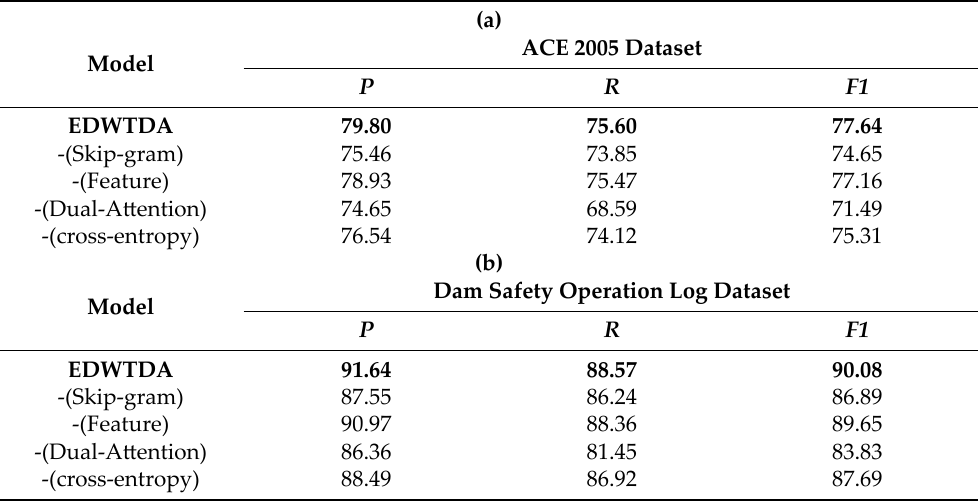
Table 7. (a). ACE 2005 dataset ablation experiment. (b). Dam safety operation log dataset ablation experiment.